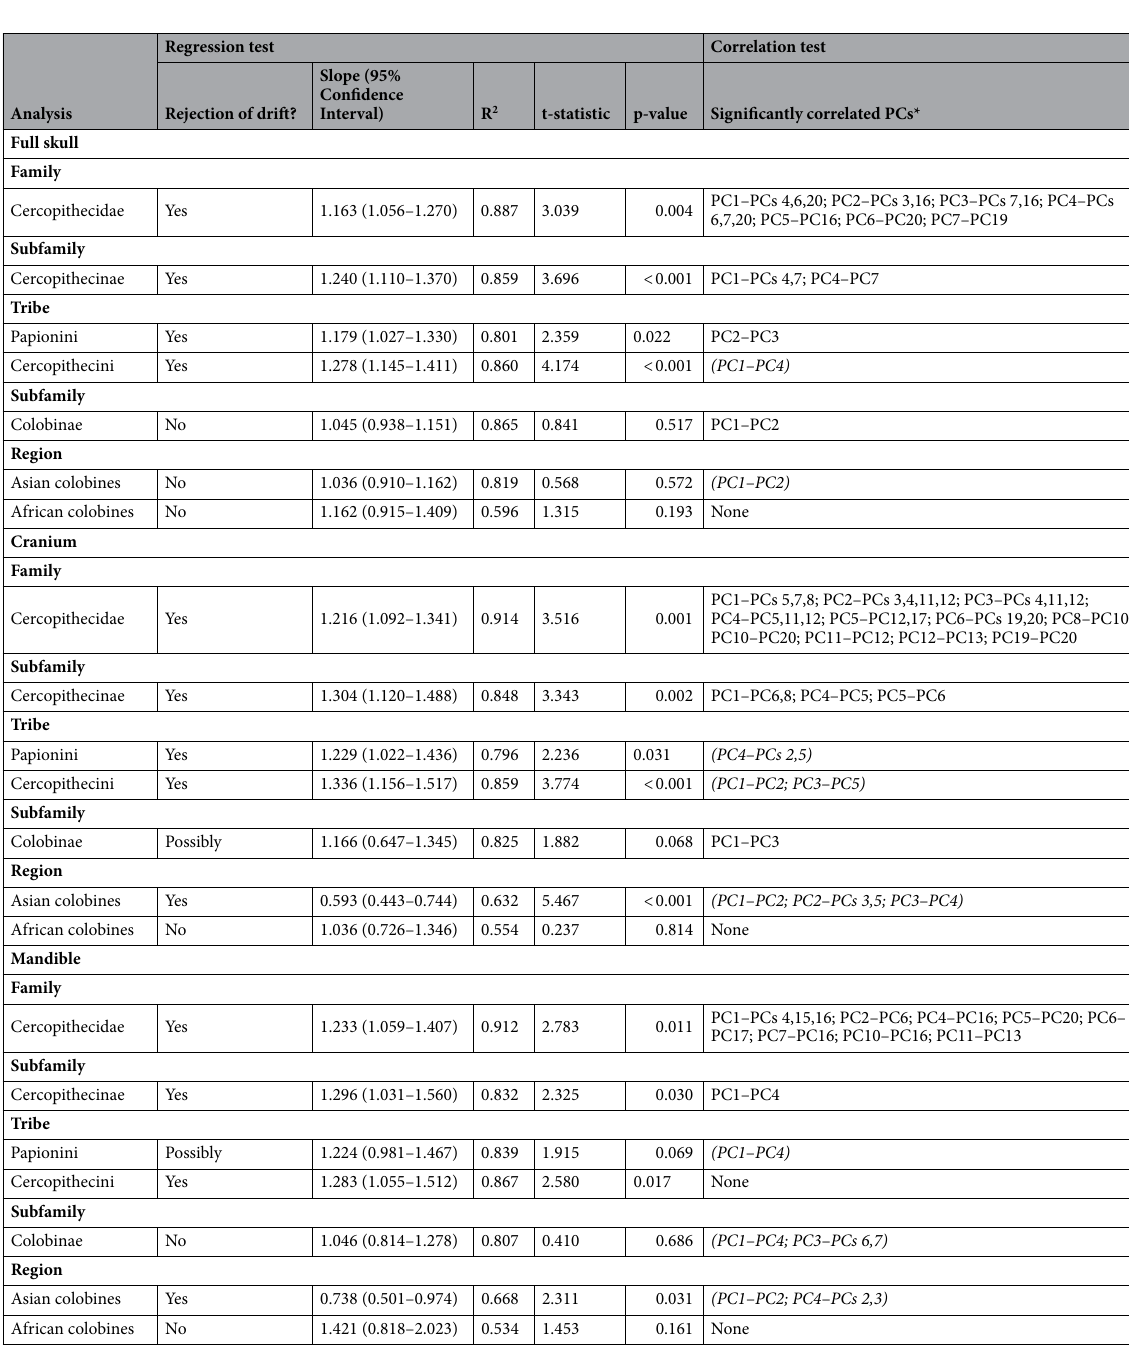
Table 1. Results of regression analysis of between- versus within-group variance, and between-group principal component (PC) correlation analysis as tests for genetic drift # . *Full PC correlation results are provided in Supplementary Info. Italicized comparisons in parentheses are those with p-values below 0.05 that do not meet the Bonferroni